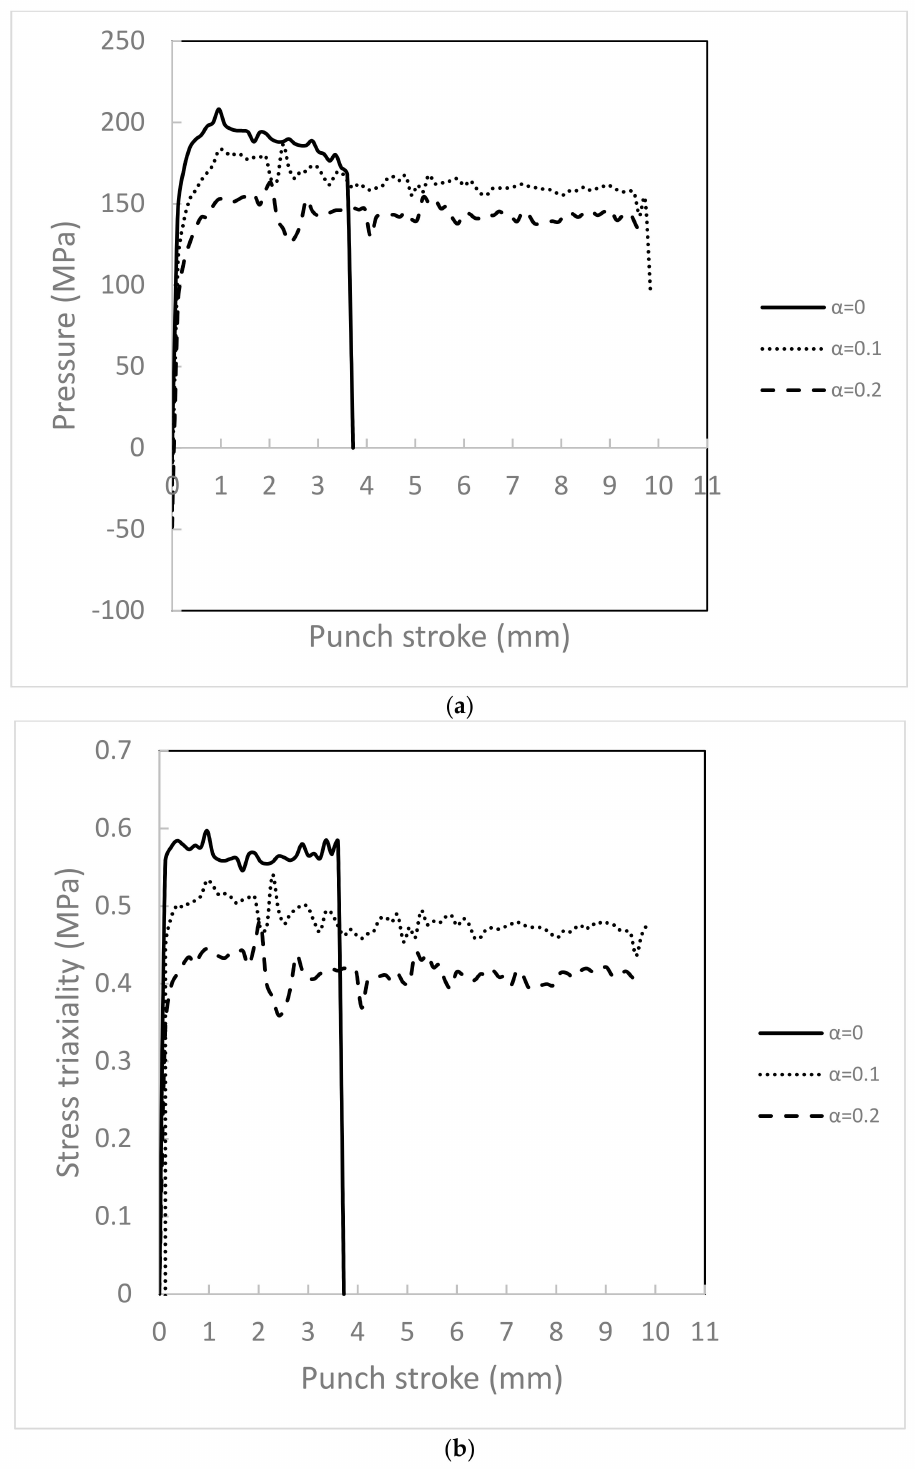
Figure 13. Effect of superimposed hydrostatic pressure on ( a ) hydrostatic pressure and ( b ) stress triaxiality at point A for a sheet with width = 10